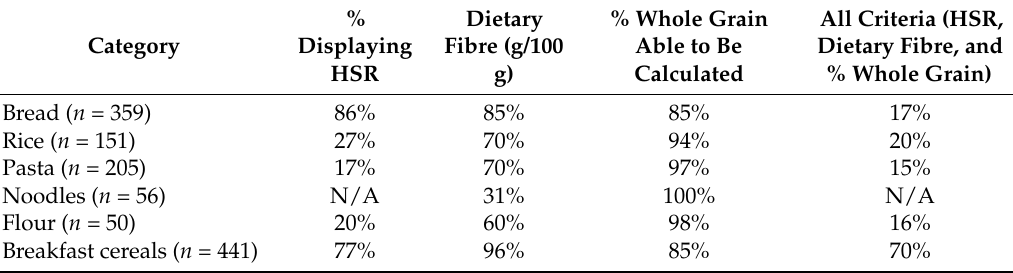
Table A2. Meeting inclusion